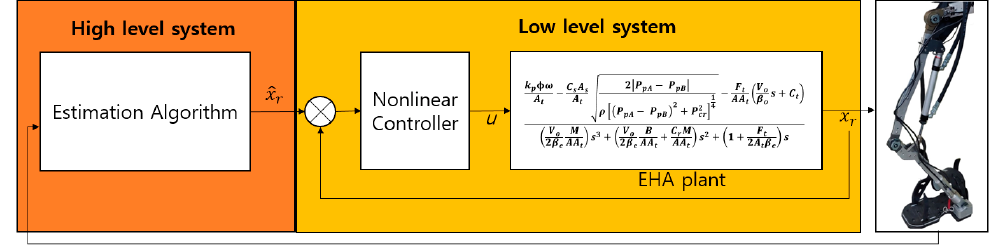
Figure 8. System block diagram of the estimated algorithm combined with the EHA [9].